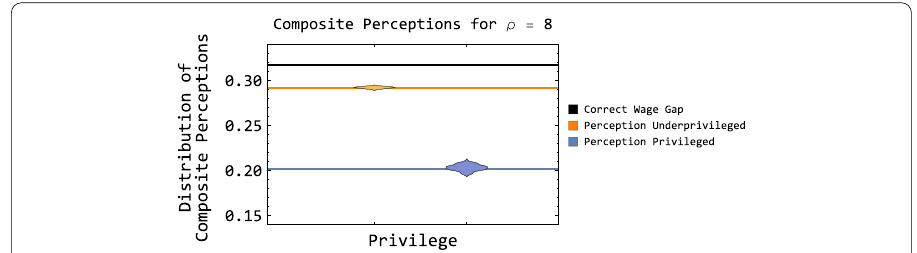
Fig. 7 Violin plots for the composite perceptions of privileged and underprivileged agents for the empirical calibration and ρ =